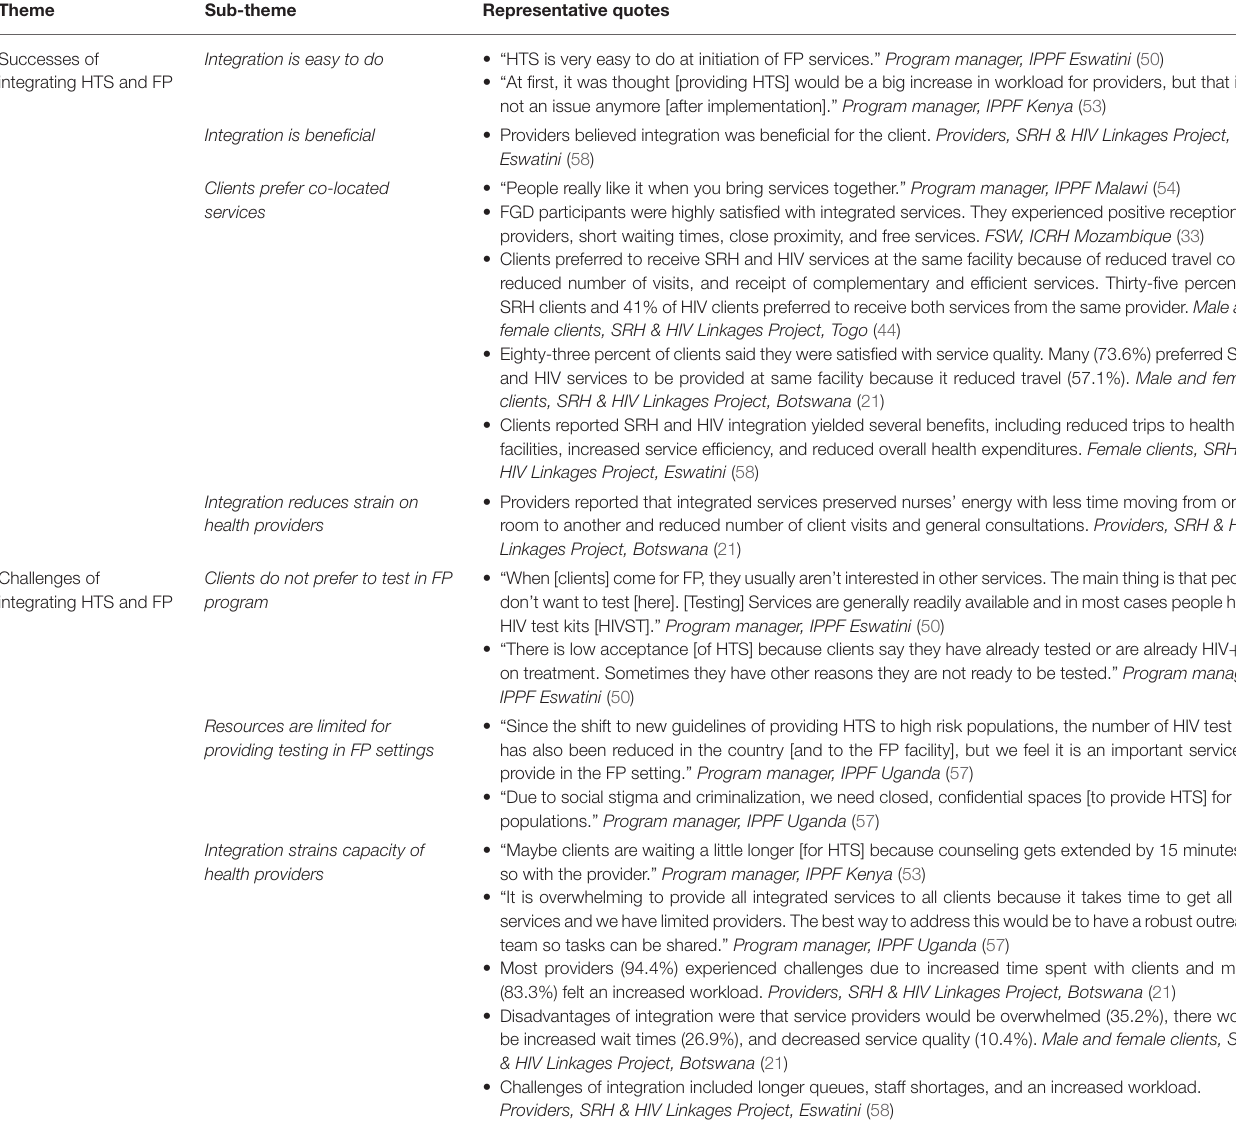
TABLE 2 | Perspectives of clients, providers, and program managers on successes and challenges of integrating HTS in FP programs.